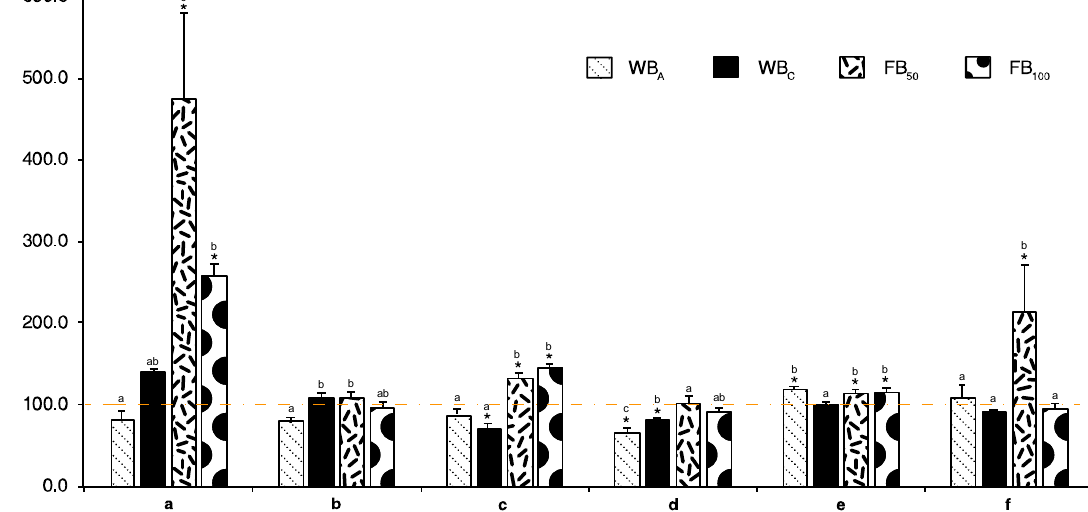
Figure 1. Effect of insect predation on production of stress compounds, and primary and secondary metabolites in white cabbage: ( a ) Superoxide, ( b ) total soluble proteins, ( c ) phenylalanine, ( d ) tyrosine, ( e ) total phenols content, and ( f ) total flavonoid content. WB A , adult cabbage butterflies (egg laying and hatching larvae), WB C 2nd instar larvae, FB 50 fifty flea beetles per box, and FB 100 , one hundred flea beetles per box. All bar values were recalculated relative to the compound content in untreated samples taken as 100% (dashed line). Data are means of three repeats ± SE. The asterisk (*) represents a significant difference between insect-damaged plants and controls, and different letters between the values of one compound. p < 0.05 by Fisher’s least significant difference (LSD) test.